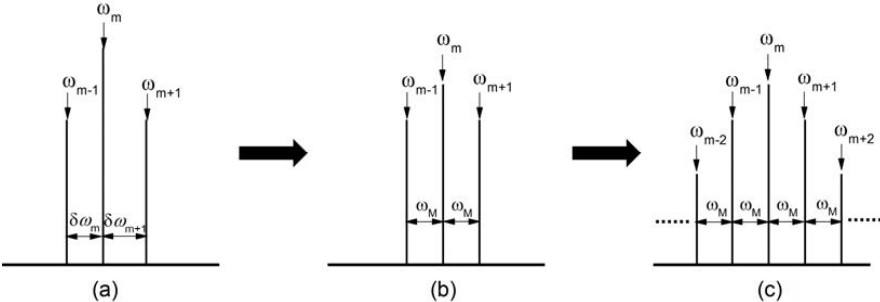
Figure 5. Schematic diagram of active mode-locking in frequency domain. ( a ) Spectrum of free-running emission. ( b ) Modulation is applied on a laser. ( c ) Laser is mode-locked.